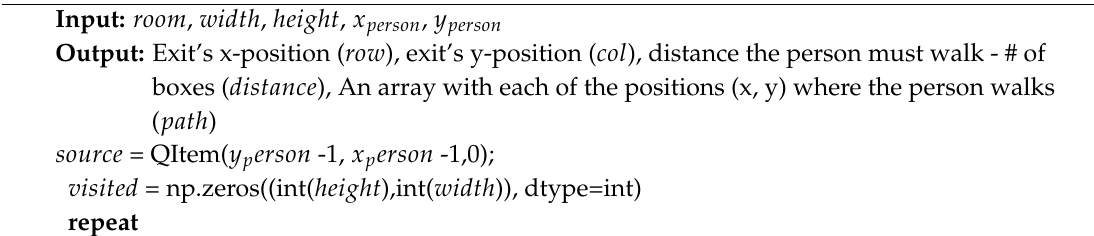
Algorithm A2: Get the distance to walk with